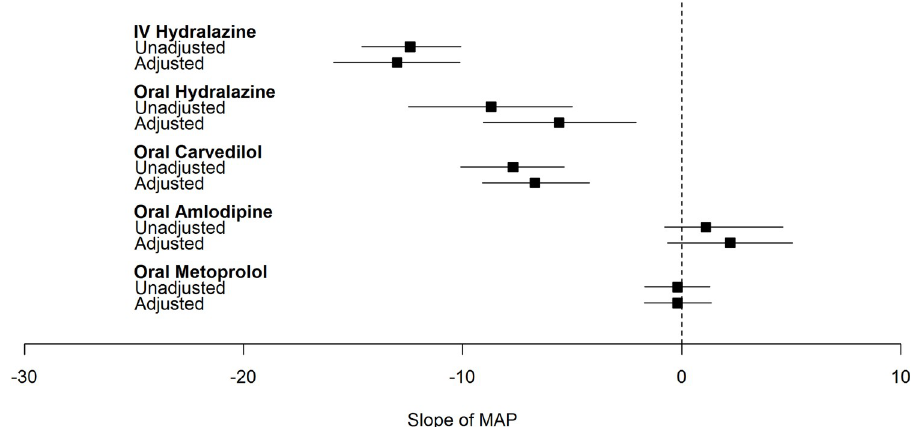
Fig 2. Plot of effect estimate ( β [95%CI]) of common antihypertensives on slope of mean arterial pressure within 6 hours of severe inpatient hypertension development. Adjusted for age, sex, race, ethnicity, ward, comorbidities (congestive heart failure, cardiac arrythmia, valvular disease, pulmonary circulation disorder, peripheral vascular disease, hypertension, paralysis, other neurological disorders, chronic pulmonary disease, diabetes, hypothyroidism, renal failure, liver disease, peptic ulcer disease excluding bleeding, AIDS/HIV, lymphoma, cancer, rheumatoid arthritis/collagen disorder, coagulopathy, obesity, weight loss, fluid and electrolyte disorders, blood loss anemia, deficiency anemia, alcohol abuse, drug abuse, psychosis, depression), baseline laboratory values (sodium, potassium, chloride, bicarbonate, BUN, eGFR, WBCC, platelet count, hemoglobin, hematocrit), NSAID use 0–6 hours before time of severe inpatient HTN, crystalloid use 0–6 hours before time of severe inpatient HTN, steroid use 0–6 hours before time of severe inpatient HTN, narcotic use 0–6 hours before time of severe inpatient HTN, sedative use 0–6 hours before time of severe inpatient HTN, maximum MAP before time of severe inpatient HTN development, minimum MAP before time of severe inpatient HTN development, coefficient of variation of MAP before time of severe inpatient HTN development.